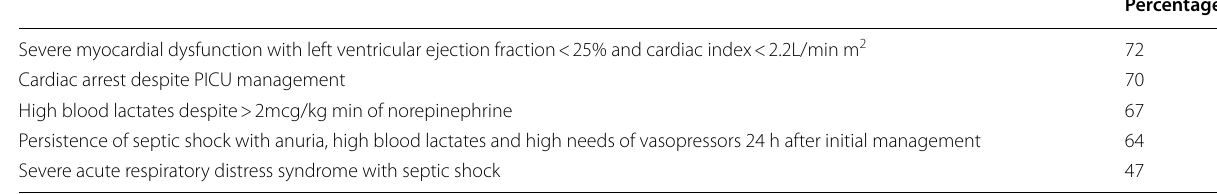
Table 1 Clinical situations most considered for extra-corporeal life support in pediatric septic shock (percent of responders grading ≥